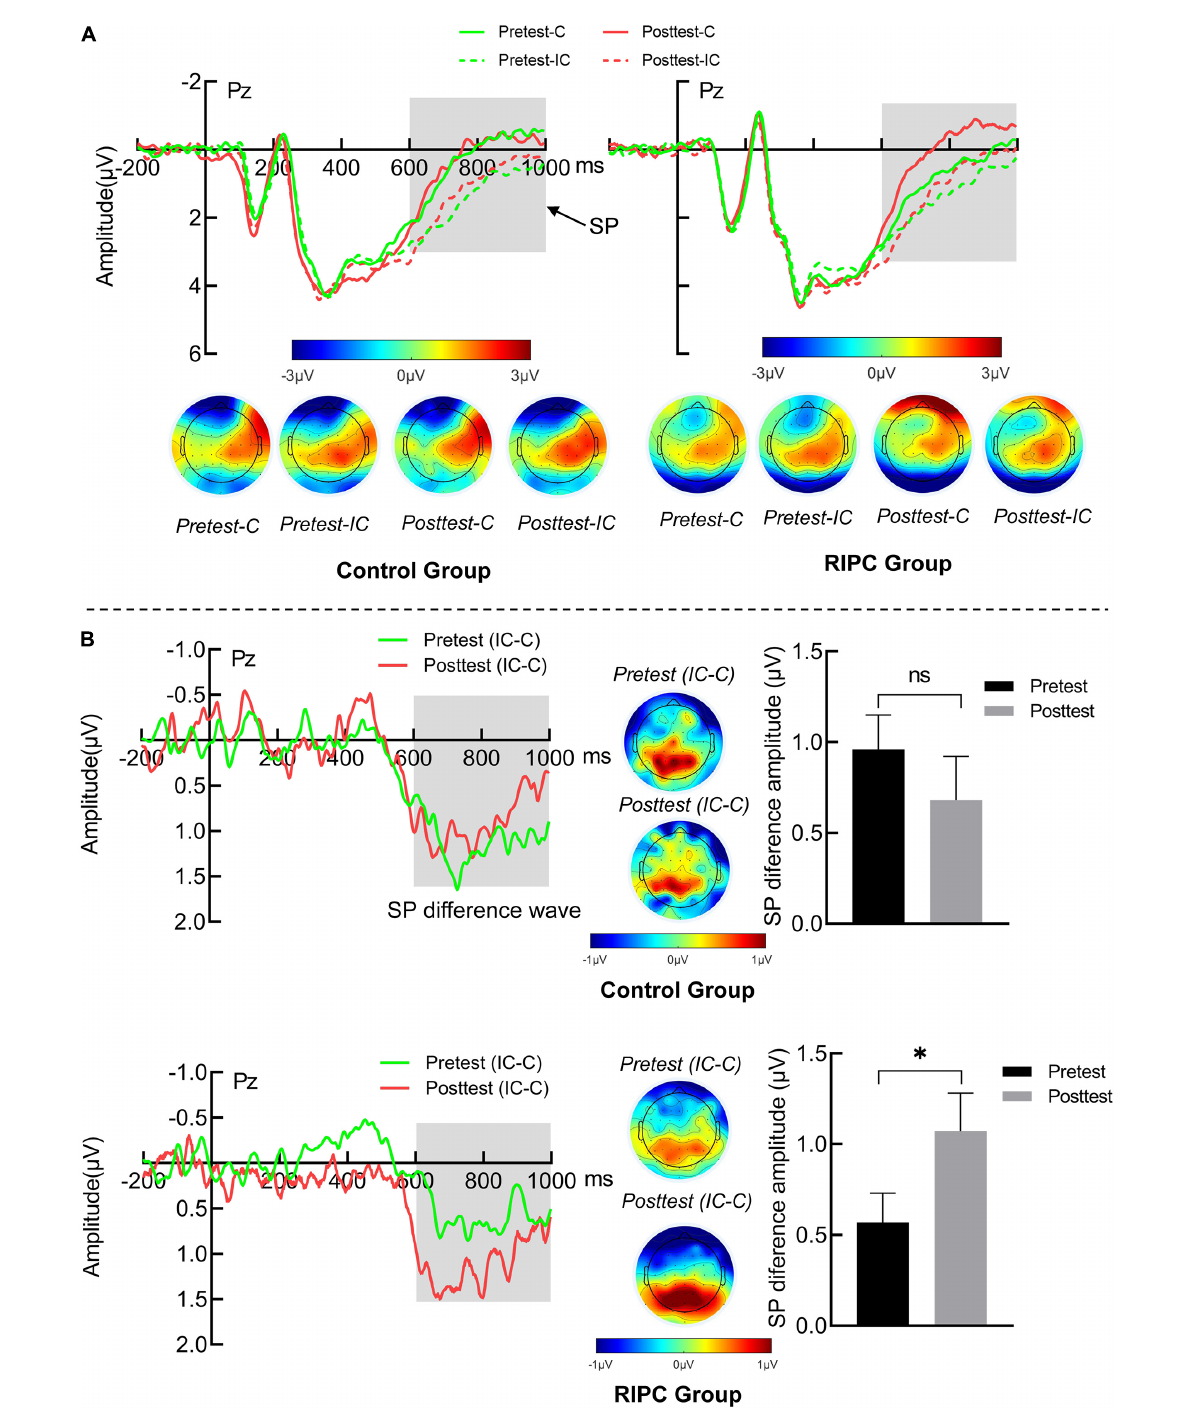
FIGURE5 (A) The SP grand average waveform (Pz) and topographical map of two groups. (B) The averaged difference wave and topographical map of SP in two groups. The dark gray rectangles represent the measure time window of SP. Error bar represents the stand error; Pretest: before treatment, Posttest: immediately after treatment. C: Congruent, IC: Incongruent, IC-C: Incongruent minus Congruent. ns, no significance between the average difference wave of pretest and posttest. ∗ Significant difference ( P < 0.05) between the average difference wave of pretest and